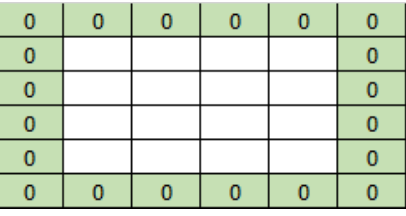
Figure 4. Zero padding input.